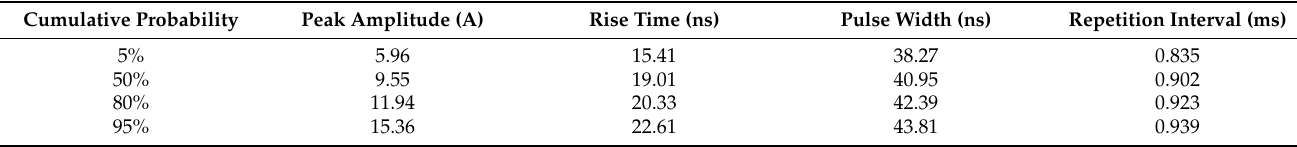
Table 3. Quantile points of the main cumulative probability of each